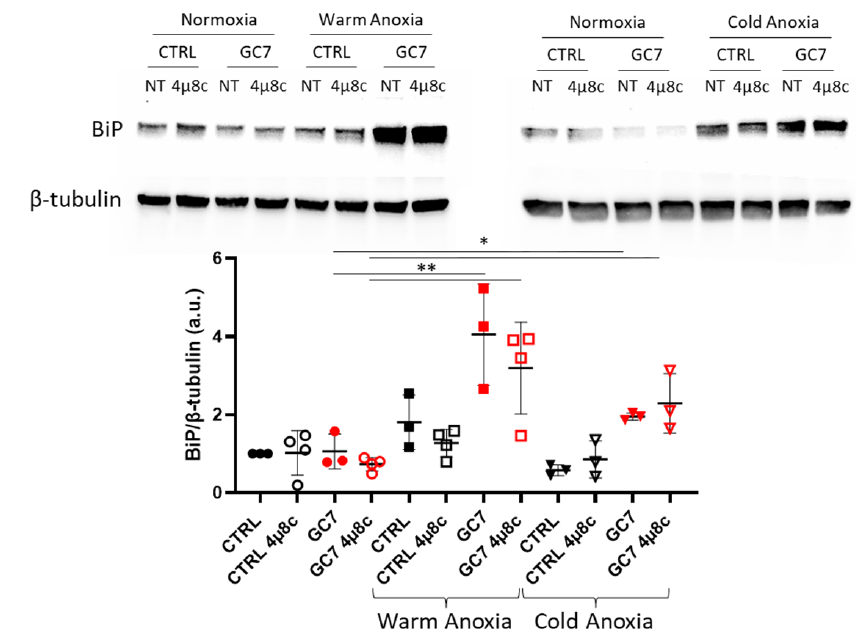
Figure 7. Impact of 4 µ 8c treatment on BiP protein level. PCT cells pretreated for 8 h either with a vehicle or with 30 µ M GC7 and 24 h later exposed to either warm (37 ◦ C, 24 h) or cold (4 ◦ C, 16 h) anoxia ( ≤ 0.1% O 2 ), in presence or not of 1 µ M of the IRE-1 α inhibitor 4 µ 8c. At the end of the experiment cells were lysed for protein expression analysis. Representative western blots of BiP and β -tubulin protein levels. Scatter plot representation of individual values along with mean ± SD for each condition, n = 3–4. * = p ≤ 0.01; ** = p ≤